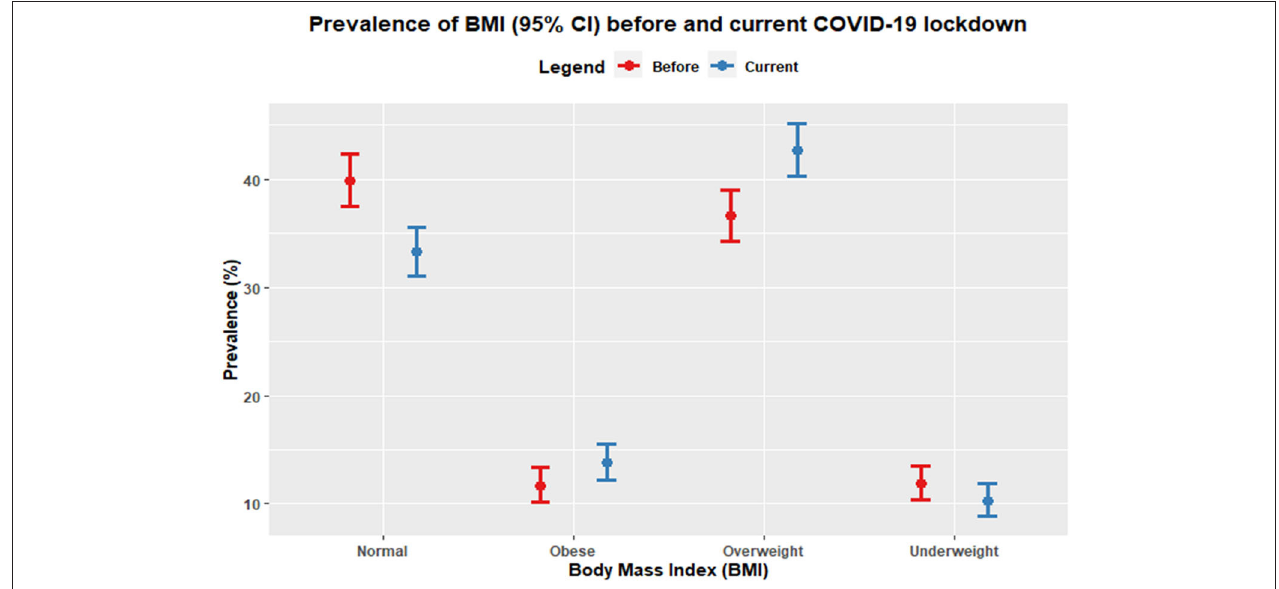
FIGURE 1 | The prevalence of body mass index (BMI) “before” and “current or during” the COVID-19 lockdown among the university students of